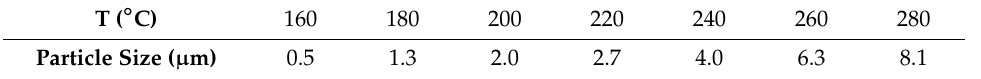
Figure 2. Original particle size distribution (PSD) and particle number concentration (PNC) of monodisperse particles. Table 1. The relationship between temperature and particle size in the PALAS